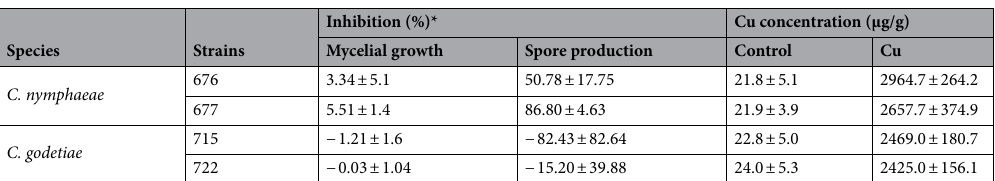
Table 2. Average values and standard errors of the inhibitions (%) of mycelial growth and spore production; and Cu content (µg/g) in mycelium of both Colletotrichum godetiae and C. nymphaeae , growing in Potato Dextrose Agar media Cu-amended (100 µl/ml) and unamended (control). *Negative inhibition (%) values correspond to non-inhibited (i.e., induction) mycelial growth or spore production due to the CuSO 4 treatment regarding the untreated